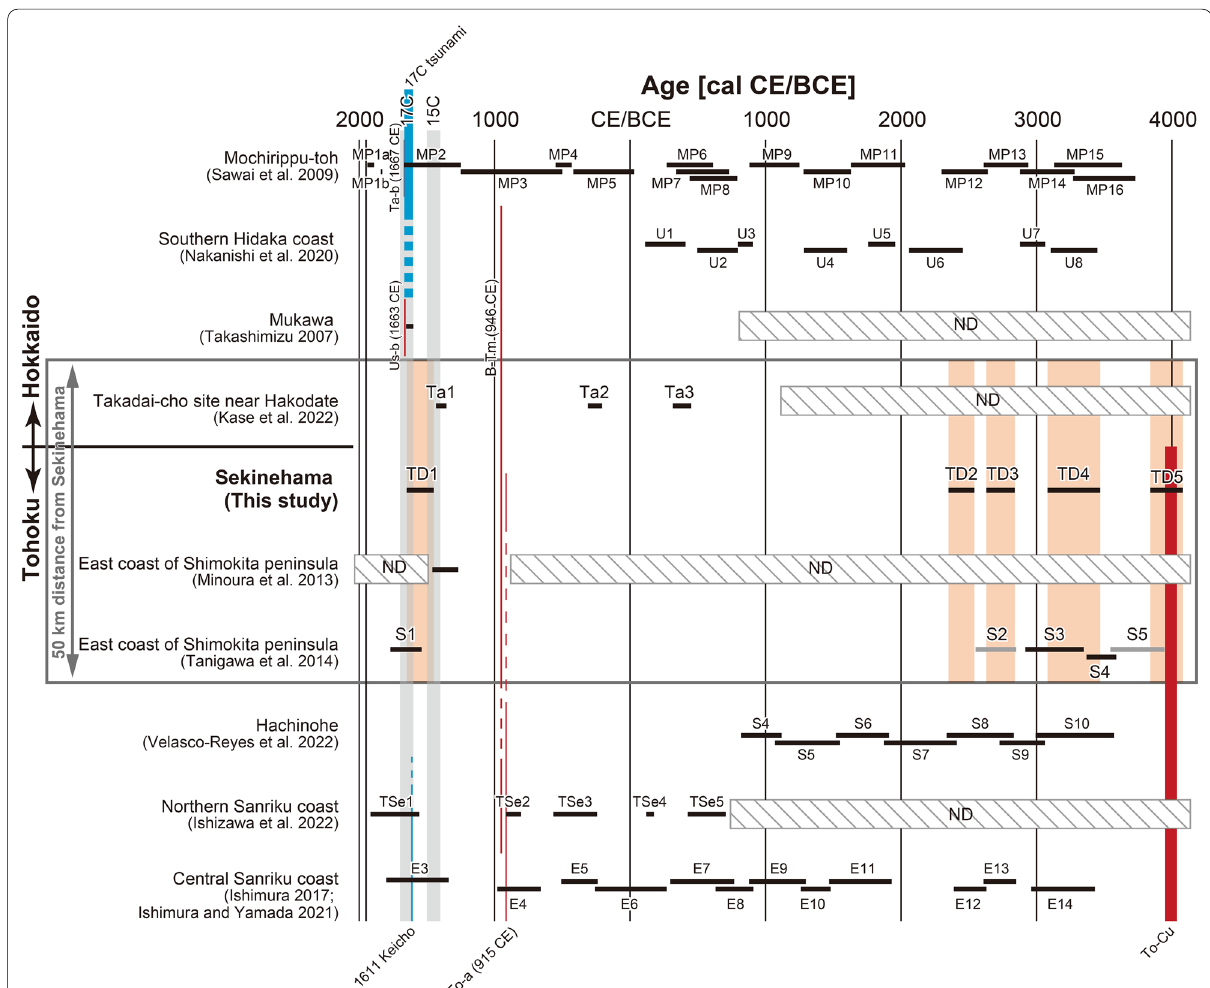
Fig. 12 Depositional ages of tsunami deposits along the Pacific Coast in Hokkaido and Tohoku regions. Ages of Us-b and Ta-b tephras are from Machida and Arai (2013). For study-site locations, see Fig.